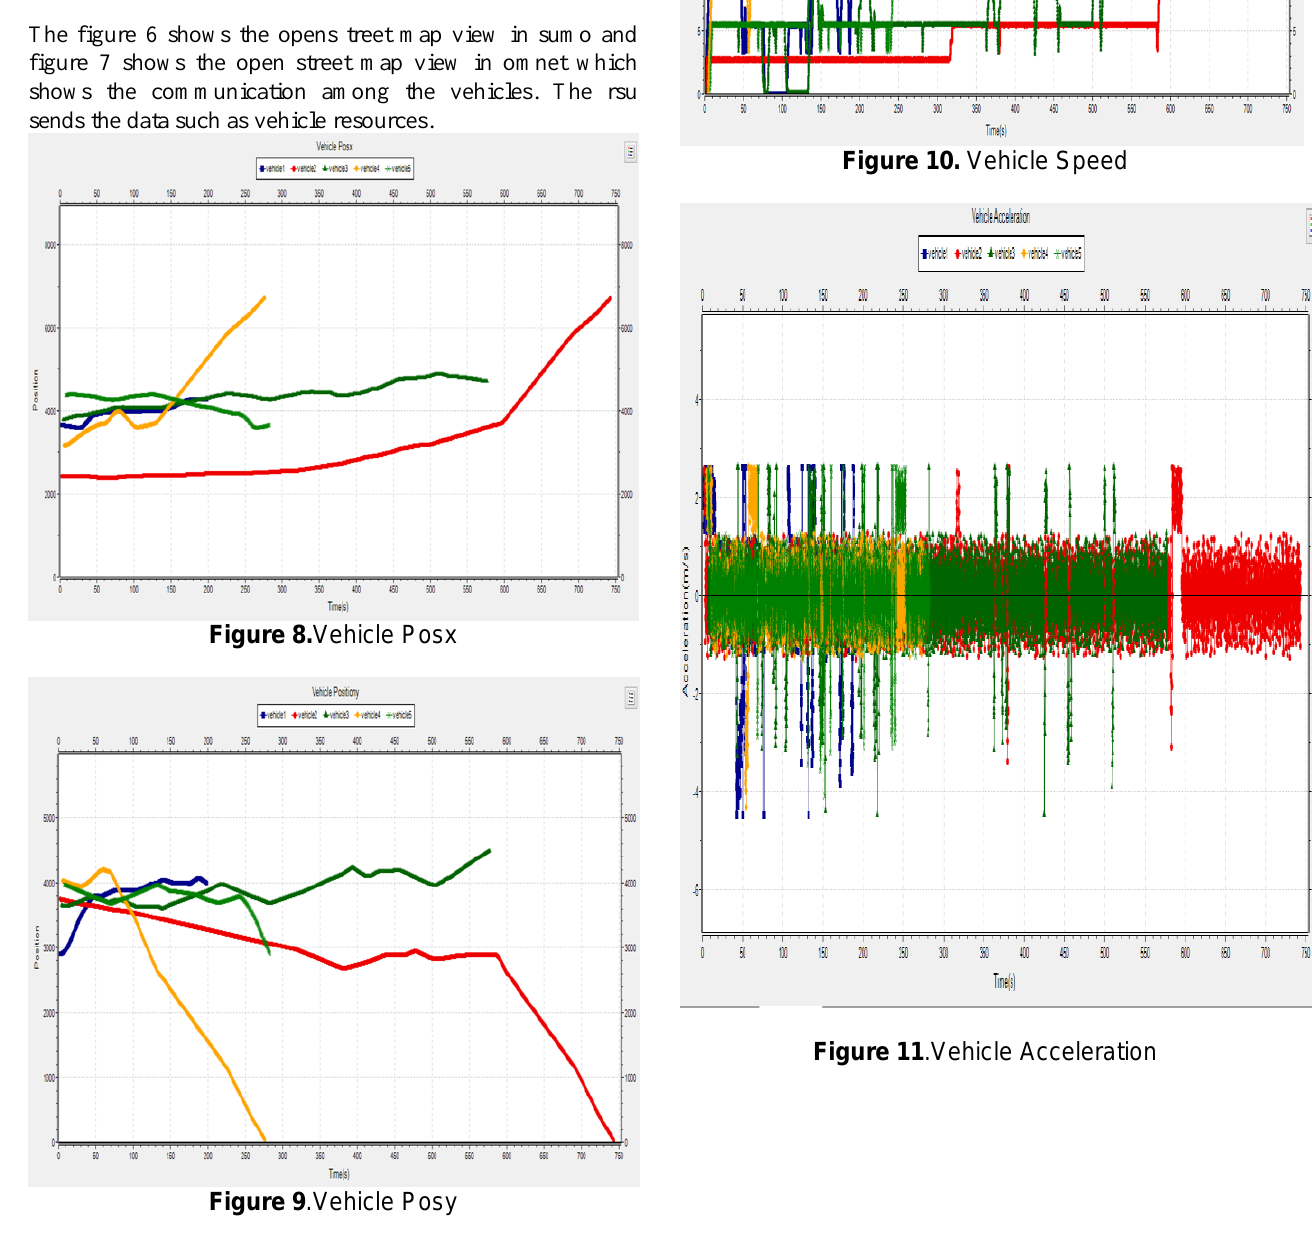
Figure 7. Open Street map in OMNET and VEIN